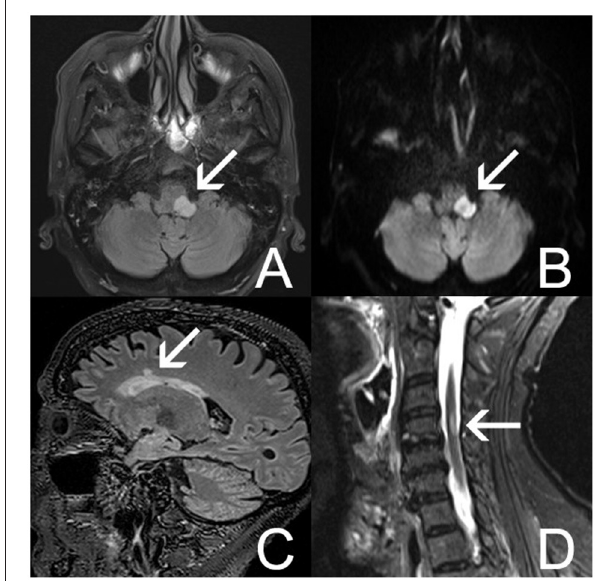
FIGURE 3 | Brain MRI (A–D) . (A) Axial fluid-attenuated inversion recovery (FLAIR) MRI image shows a well-demarcated, hyperintense lesion in the left posterolateral part of the medulla oblongata (arrow). (B) Axial diffusion-weighted imaging (DWI) shows restriction of diffusion in this lesion (arrow). (C) Sagittal FLAIR MRI image shows a nodular hyperintensity in the right frontal lobe (arrow). (D) Sagittal short tau inversion recovery (STIR) image shows a hyperintense lesion in the cervical medulla at C4